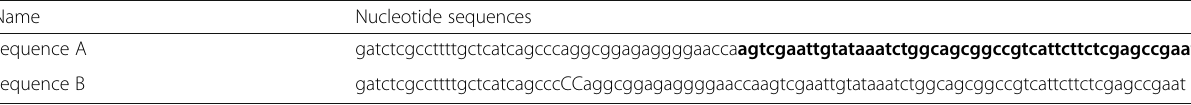
Table 6 Nucleotide sequences used to predict functional binding sites in non-coding region upstream of CYP51 in Ustilaginoidea virens Name Nucleotide